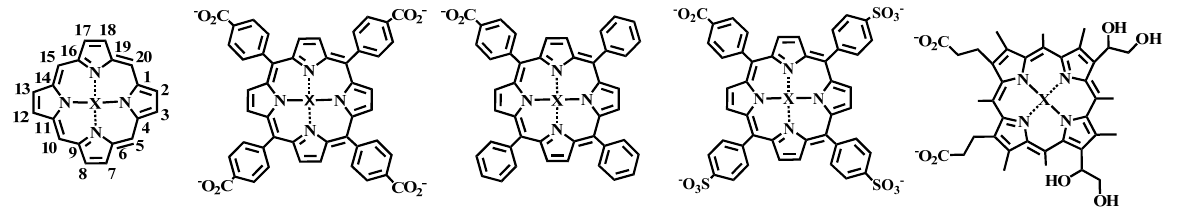
Figure 1. Structures of the porphyrin parent compound and those porphyrins used in the presented studies; from left to right: porphine, meso-tetra(4-carboxyphenyl) porphine (C TPP); 5-mono(4-carboxyphenyl)-10, 15, 20-triphenyl porphine (C 4 sulfonatophenyl)mono(4-carboxyphenyl) porphine (C 2,4 bis-ethylene glycol